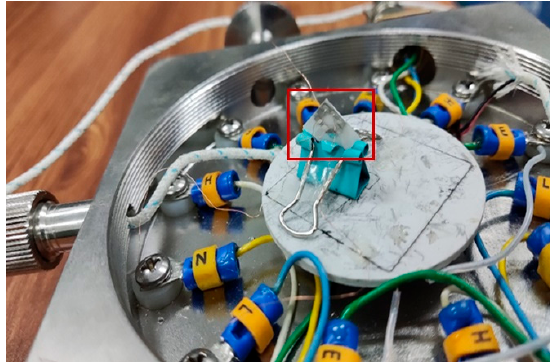
Figure 11. Test sample for out-of-plane thermal measurement (the red line frames out Pt sensor).